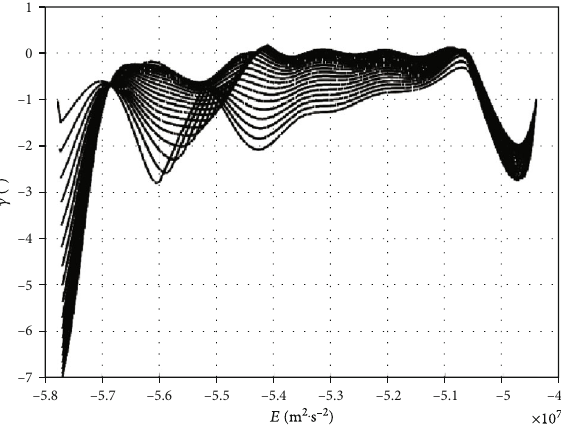
Figure 19: Lift acceleration pro fi les for Case 1.